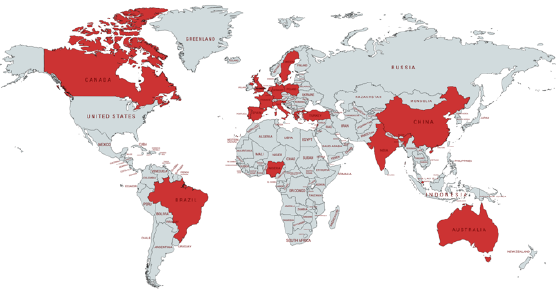
Figure 1. Map of countries of origin of the registered participants to the GeoBIM benchmark as of 15 th July